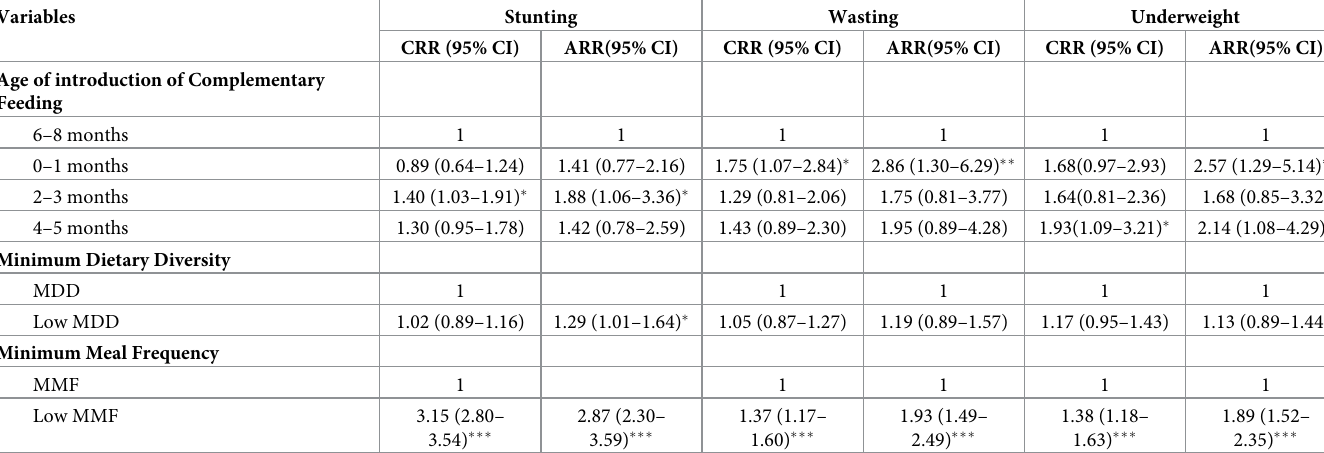
Table 2. Multilevel logistic regression: Effect of inappropriate complementary feeding practices on the nutrition status of the children. Variables Stunting Wasting Underweight CRR (95% CI) ARR(95% CI) CRR (95% CI) ARR(95% CI) CRR (95% CI) ARR(95%